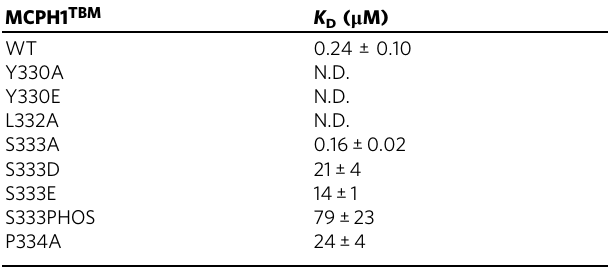
Table 2 Equilibrium dissociation constant ( K D )